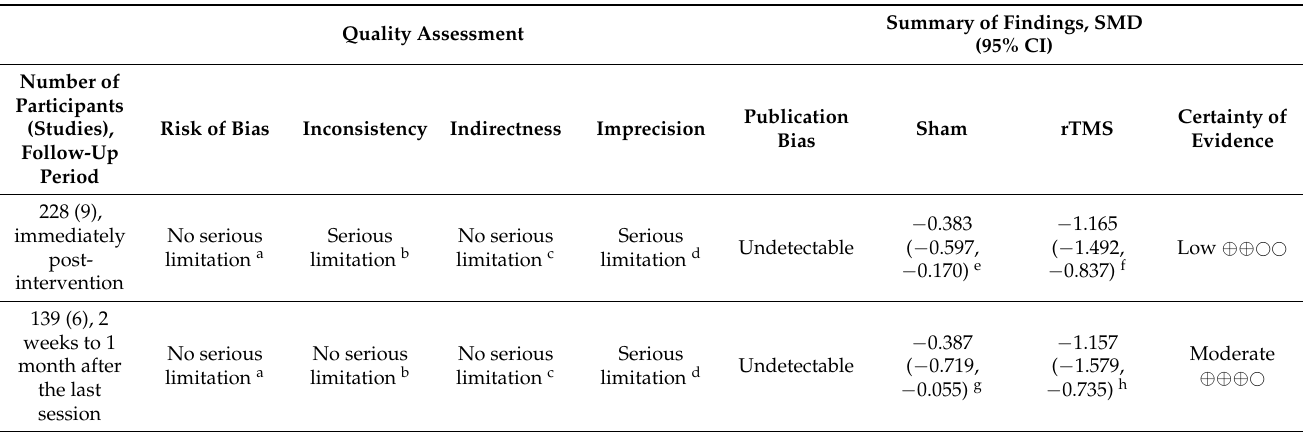
Table 6. Certainty of evidence for improvement of FIQ/FIQR scores after